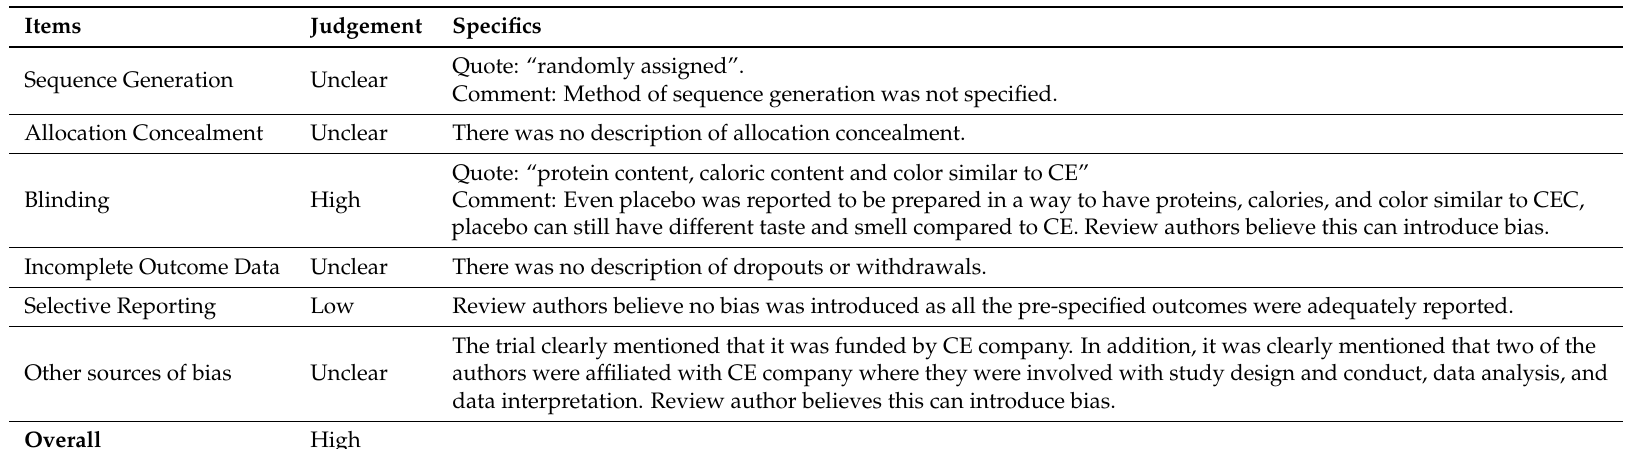
Table A6. Risk of bias assessment of Yamano 2013,